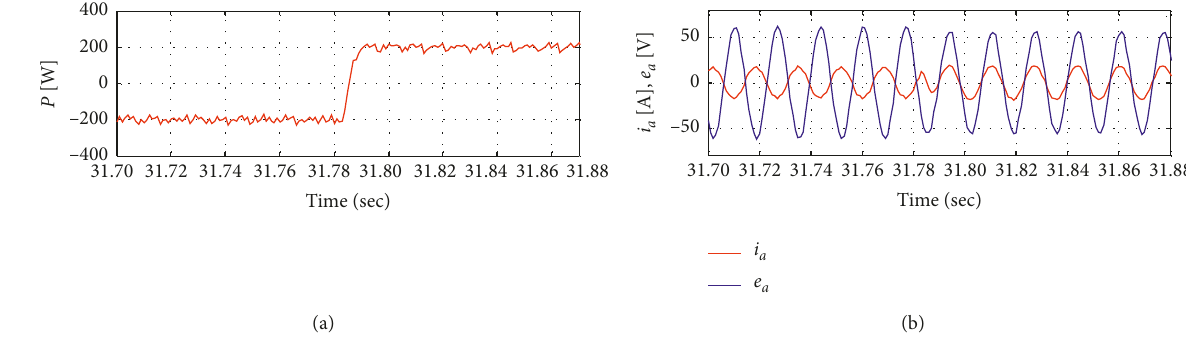
Figure 18: Experimental results of (a) active power and (b) grid-voltage and current during discharging and charging